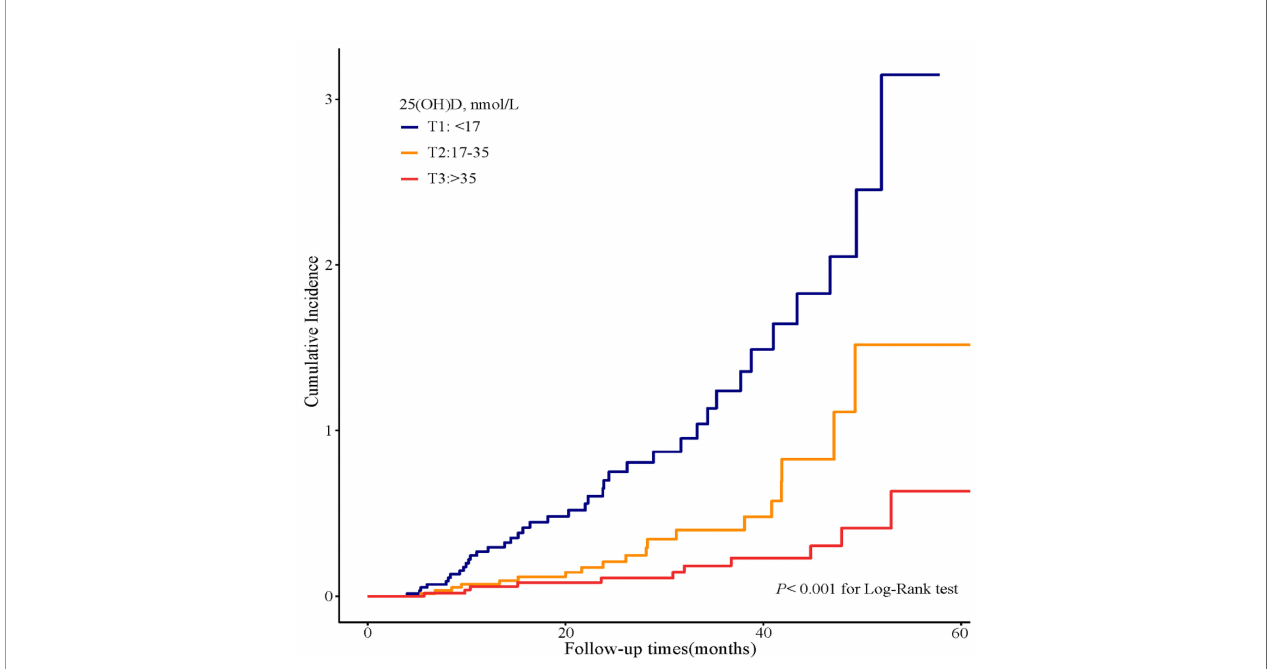
TABLE 5 | Effect of serum 25(OH)D on renal outcomes. Variable